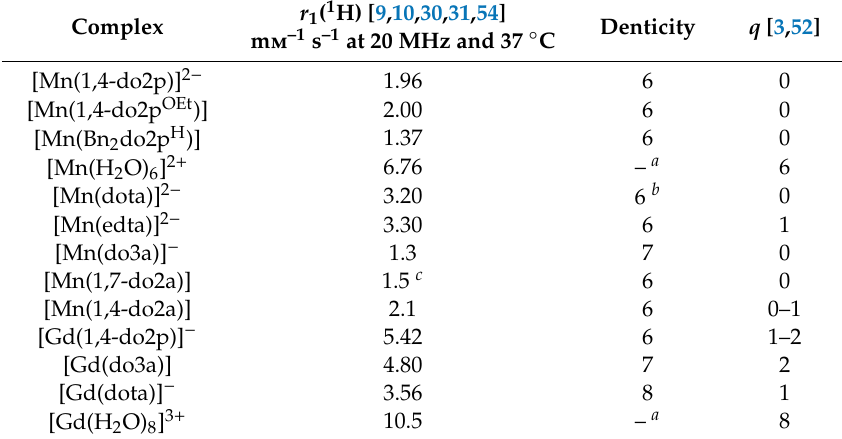
Table 4. Comparison of proton relaxivity, denticity, and hydration number q for complexes with the title and similar ligands, and for hydrated “free” metal ions (37 ◦ C, 20